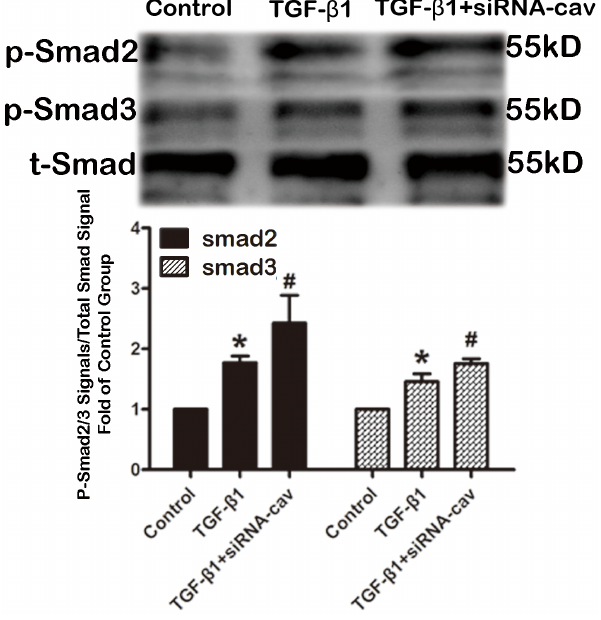
Figure 7. Downregulation of caveolin-1 increased the TGF- b 1- induced phosphorylated Smad 2/3. HAFs in the siRNA-Cav group were transfected with the caveolin-1 siRNA using Hiperfect transfection reagent following protocols provided by the manufacturer, and then HAFs were treated with 100 ng TGF- b 1 for 48 h. HAFs in TGF- b 1 group were only treated with 100 ng TGF- b 1 for 48 h. Note that downreg- ulation of caveolin-1 with the caveolin-1 siRNA increased the amount of phosphorylated Smad 2/3 compared to the TGF- b 1 group. HAFs, human atrial fibroblasts. siRNA-Cav, the caveolin-1 siRNA. p-Smad2, phosphorylated Smad 2. p-Smad3, phosphorylated Smad 3. t-Smad, the total Smad 2/3. *P , 0.05 vs. control group. # P , 0.05 vs. TGF- b 1 group. n=3 per group; measurement in triplicate for each single